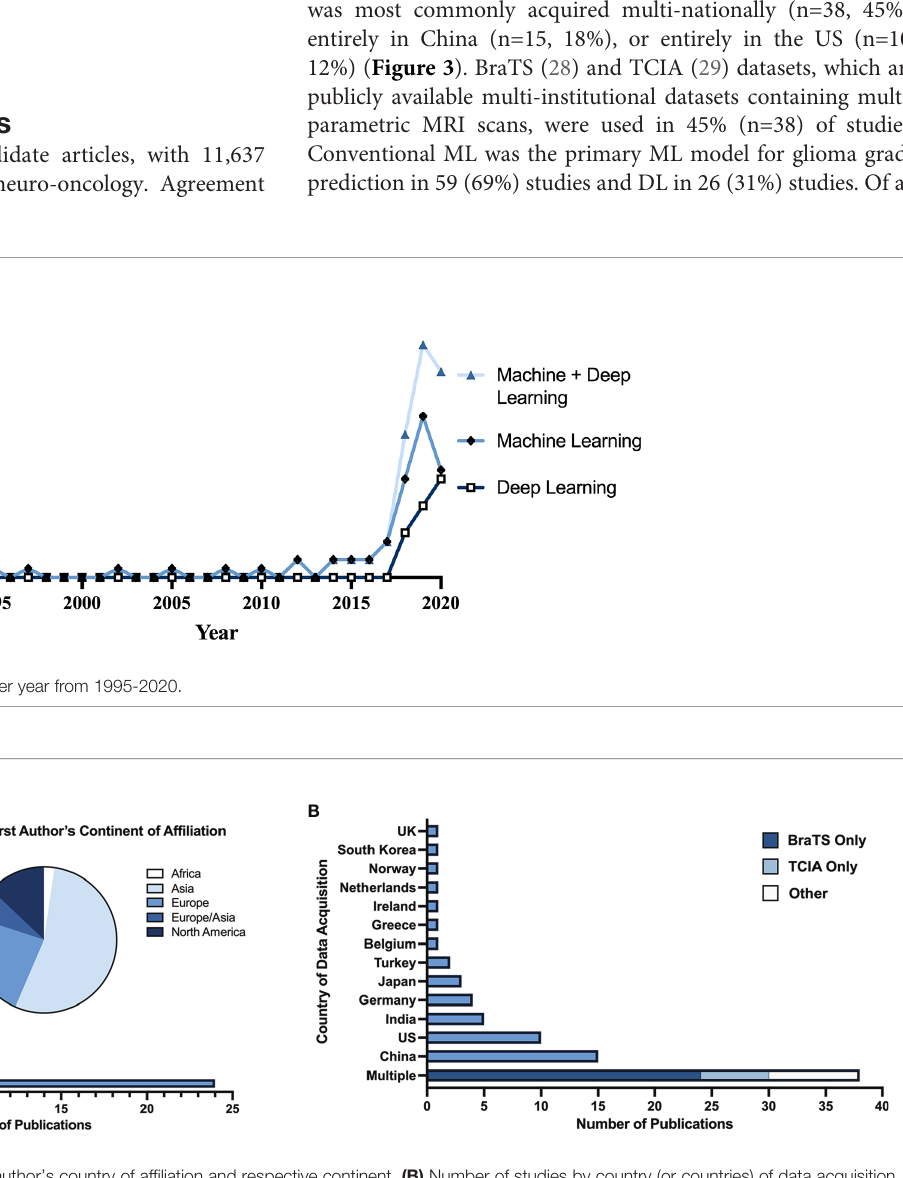
FIGURE 3 | (A) Number of studies by fi rst author ’ s country of af fi liation and respective continent. (B) Number of studies by country (or countries) of data